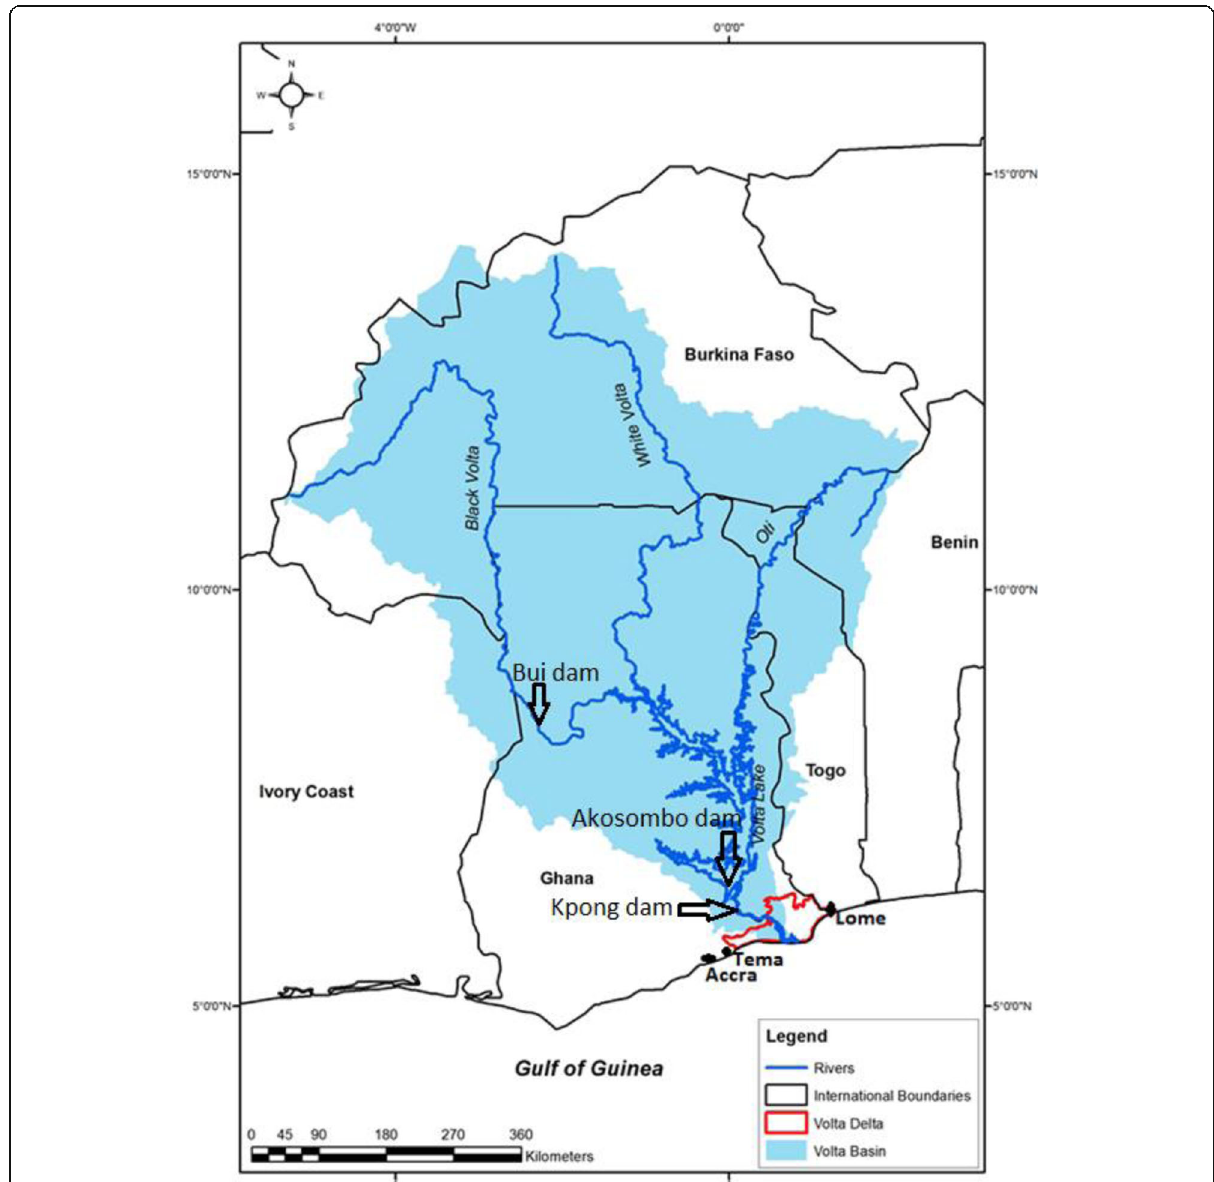
Fig. 1 Map of the Volta Basin showing the riparian countries, the Volta River, upstream catchment management, the Volta delta and the tributaries. (Source: adapted from Rodgers et al., 2006 and Appeaning Addo et al.